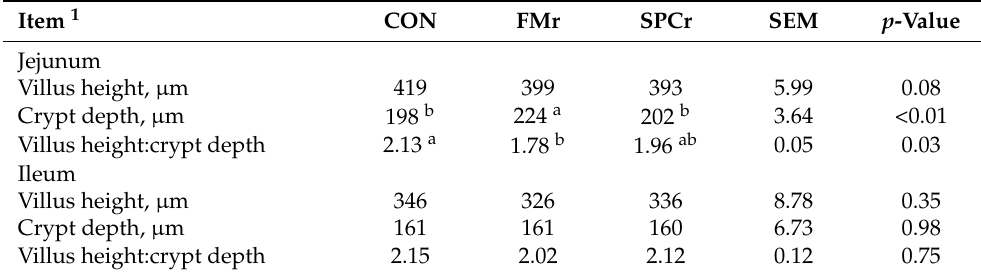
Table 5. Effects of experimental diets on intestinal morphology in weaned